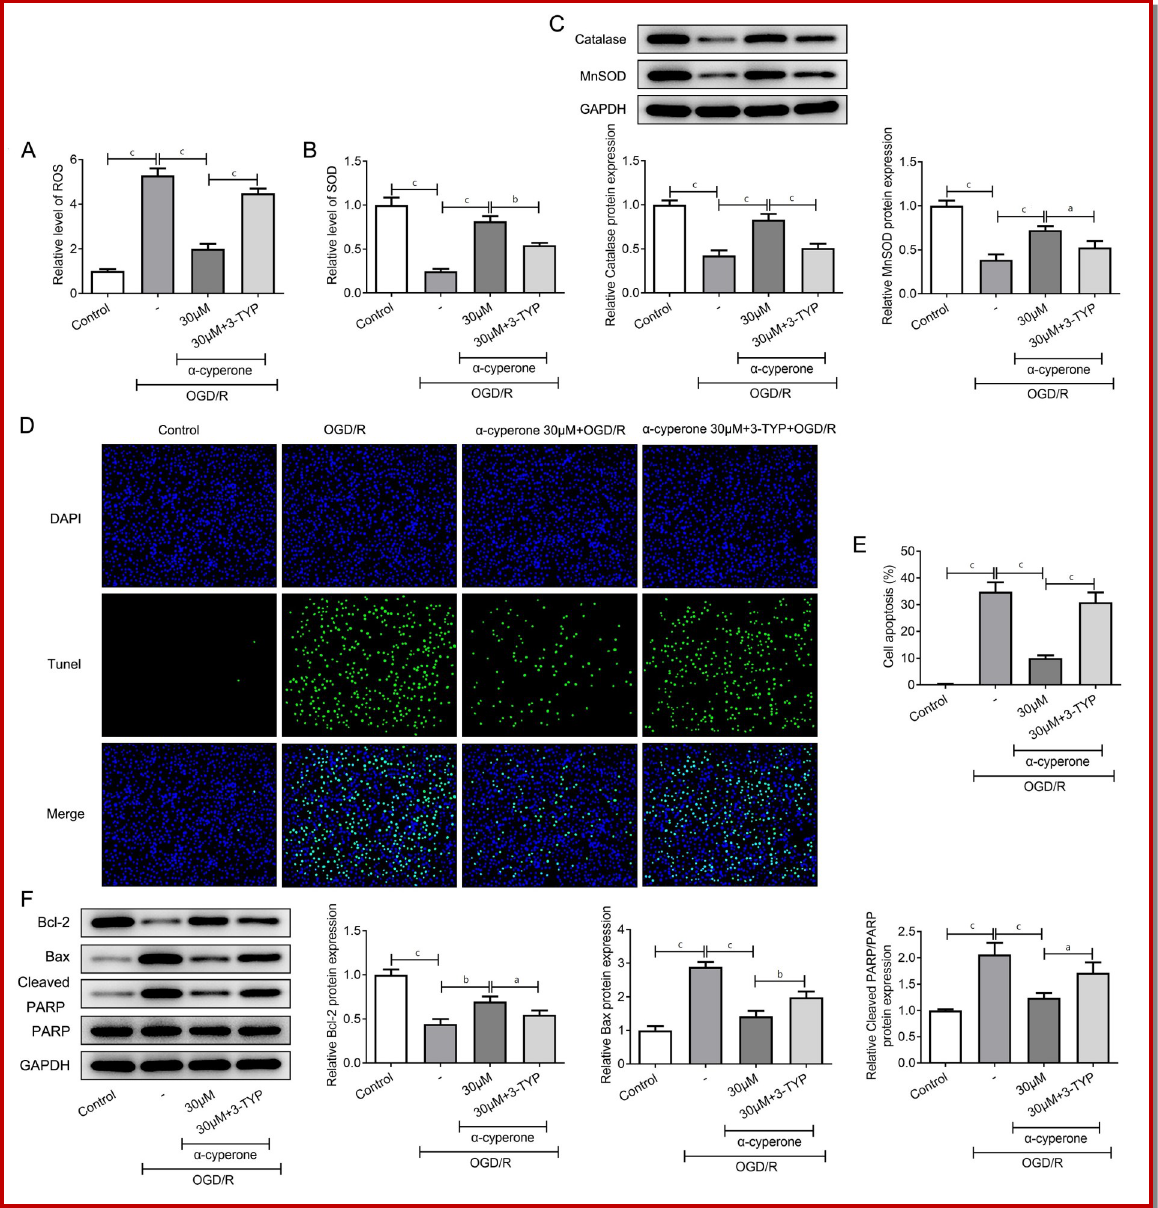
Figure 4: 3-TYP breaks the effect of α -cyperon on neuronal oxidative stress and apoptosis. The level of ROS (A) and SOD in the cells was determined using assay kits (B). The levels of catalase and MnSOD were determined using Western blotting (C). The effect of α -cyperone on the level of cell apoptosis was evaluated using TUNEL assay (D-E) and Western blotting (F). Magnifica- tion, x200. a p<0.05, b p<0.01, c